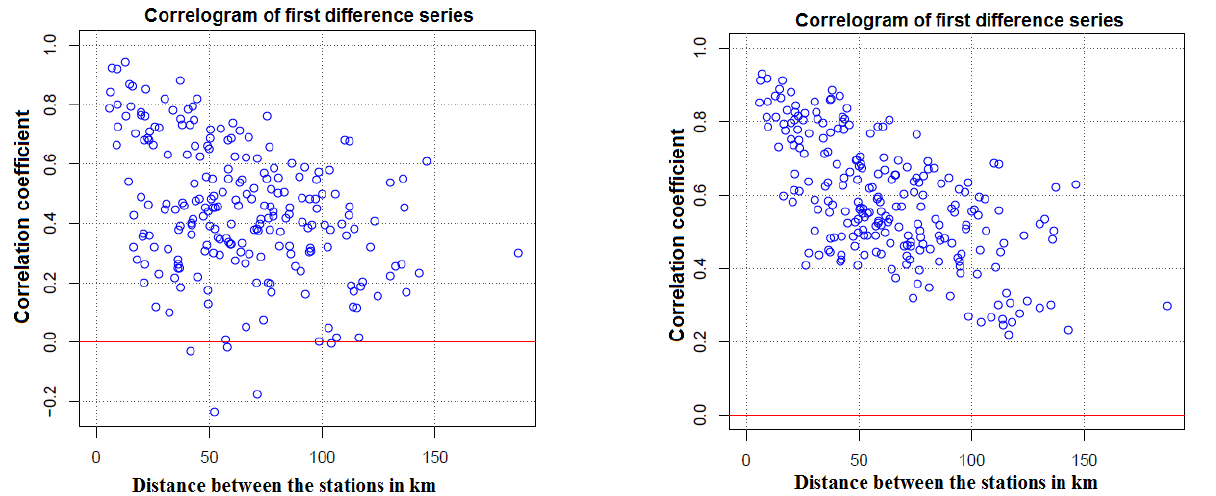
Figure 3. Correlograms of the first differences of the series stations’ raw data (on the left ) and adjusted data (to the right ).